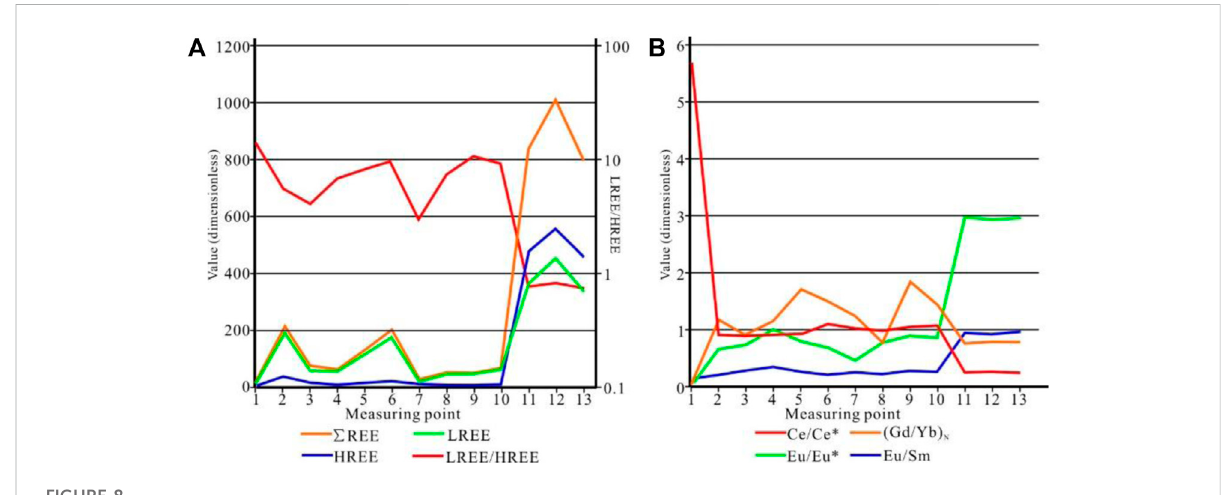
FIGURE 8 REE contents at various measuring points (A) and characteristic parameters (B)